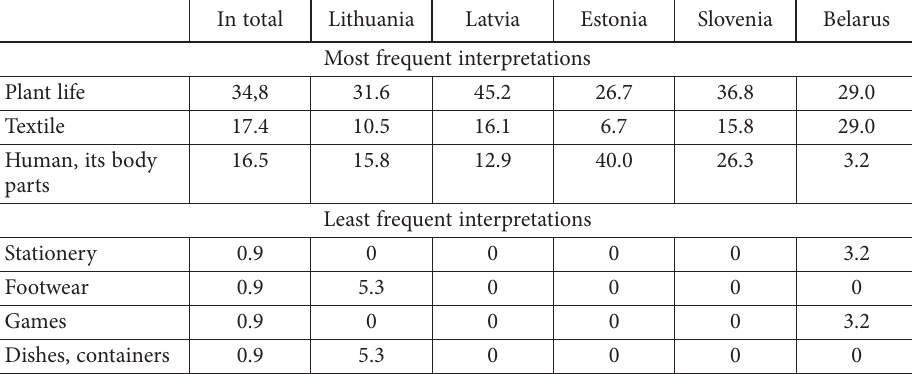
Table 6. Interpretations of Fragment 3 (%) (source: created by authors)